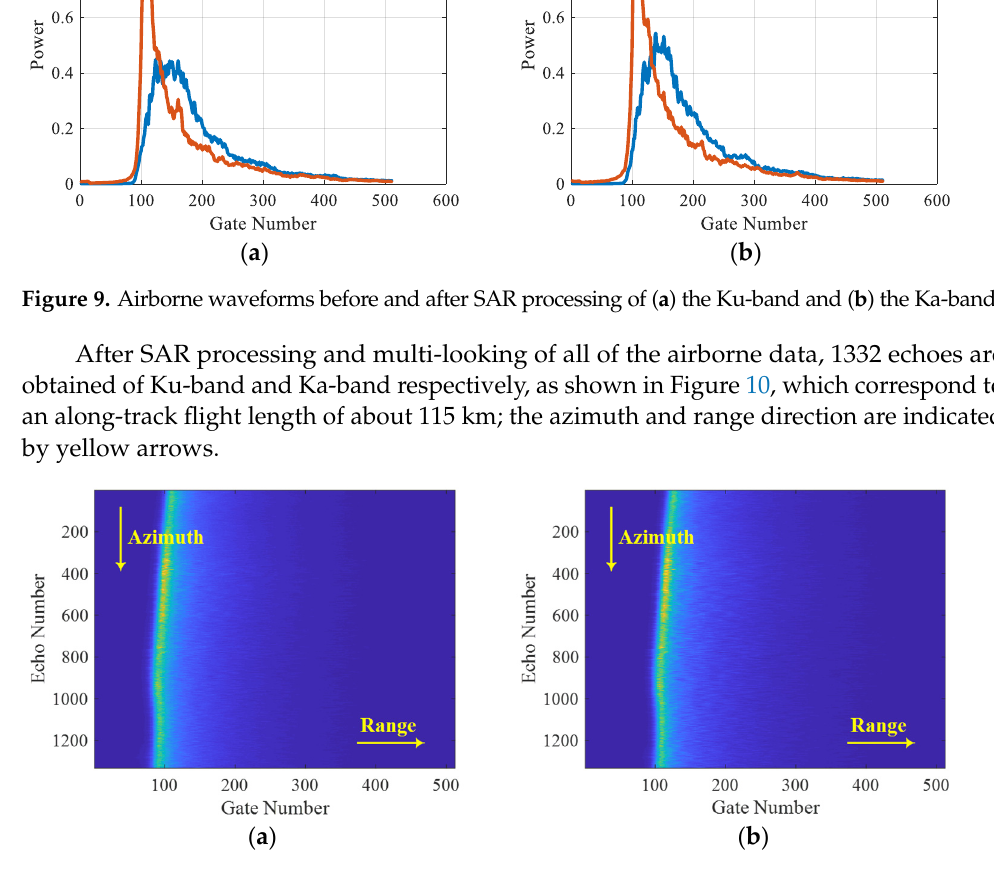
Figure 10. Airborne multi-look SAR echoes of ( a ) the Ku-band and ( b ) the Ka-band. Figure 11a shows the re-tracking iteration of a Ku-band normalized airborne